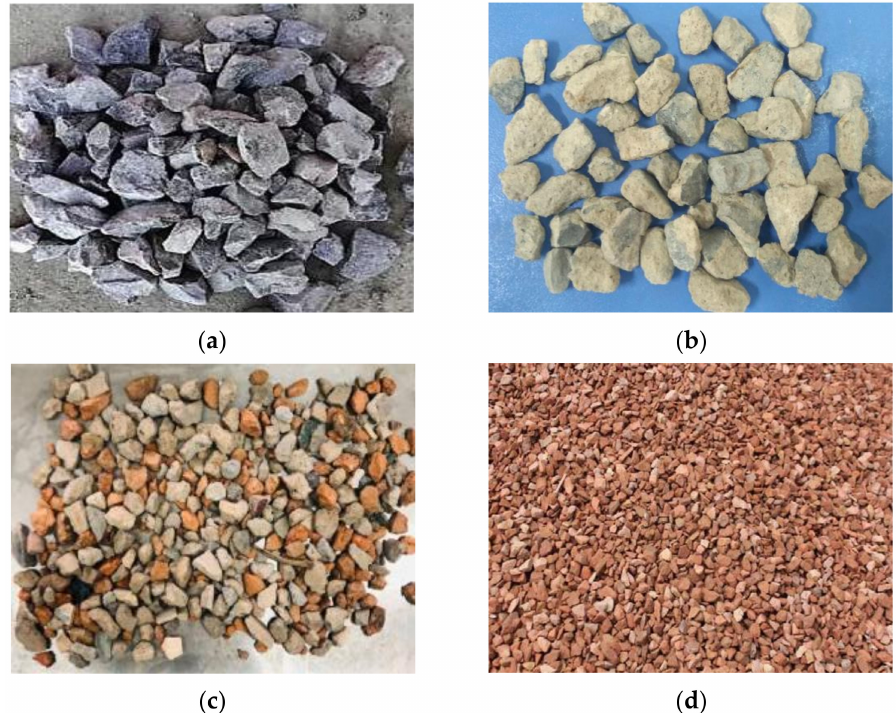
Figure 1. Appearance of aggregate: ( a ) Natural aggregate [55]; ( b ) Recycled concrete aggregate [56];